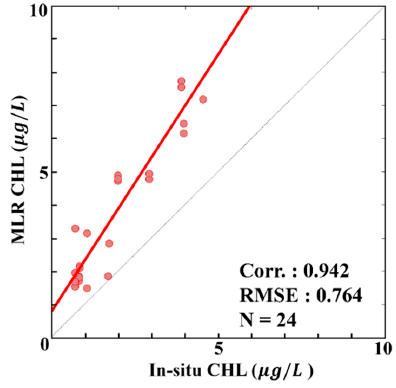
Figure 7. Comparison between calculated CHL from multiple linear regression (MLR CHL) and in-situ CHL. Table 4. Correlation between calculated CHL from MLR (MLR CHL) and in-situ CHL. Multi linear regression